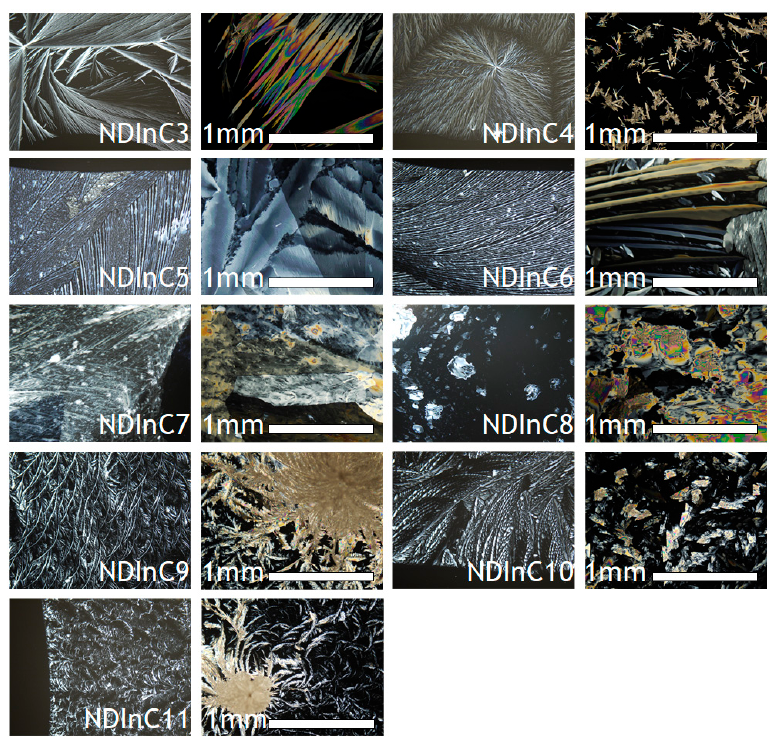
Figure 6. Morphology of the studied NDIs deposited at 25 °C on glass plates as revealed by polar- ized optical microscopy. optical